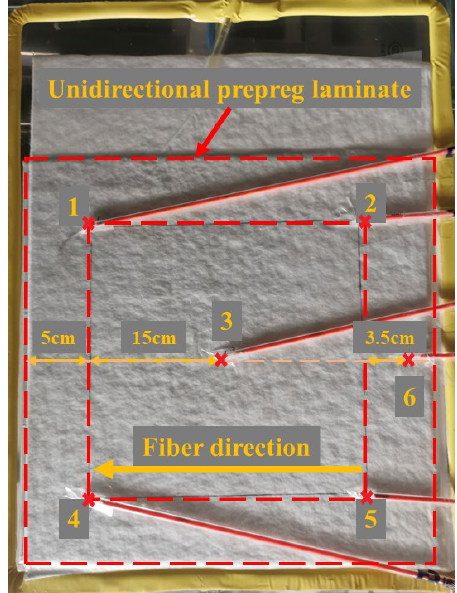
Figure 3. Photograph of the distribution of the fiber optical fluorescence probes on the bagging film. (The probes are numbered from 1 to 6, and their locations are corresponding to six red crosses as illustrated in this figure).